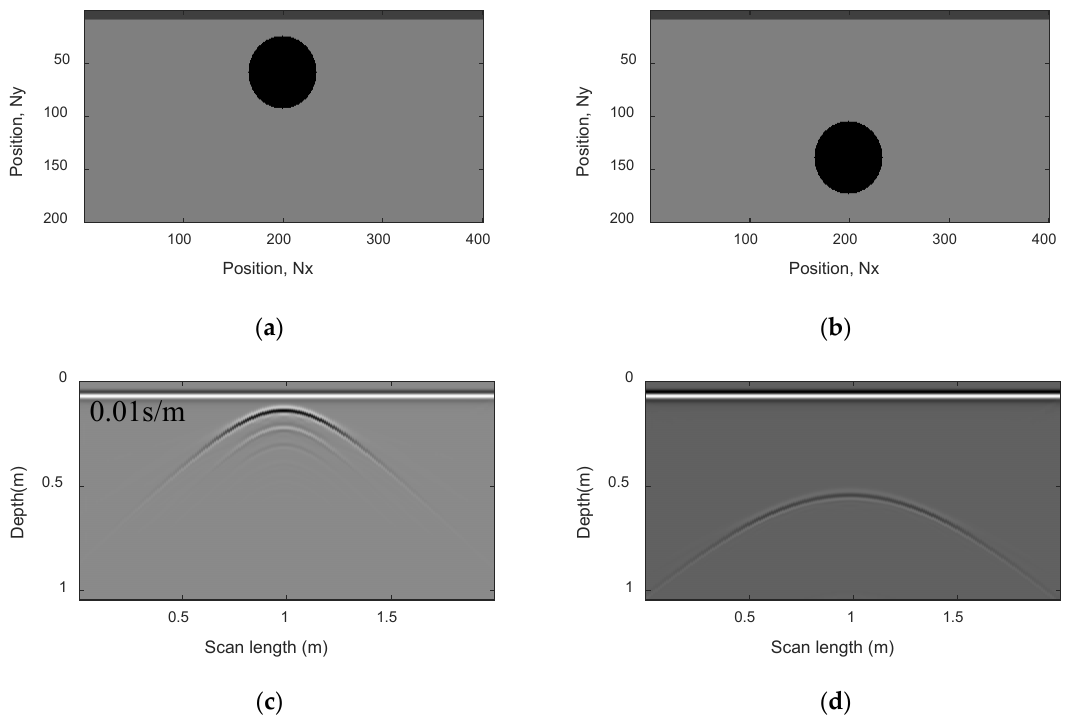
Figure 4. Simulation results( a , b ) two conductive objects buried in a wet sand medium at a depth of 0.3 and 0.7 m ( c , d ) object detection radargrams.